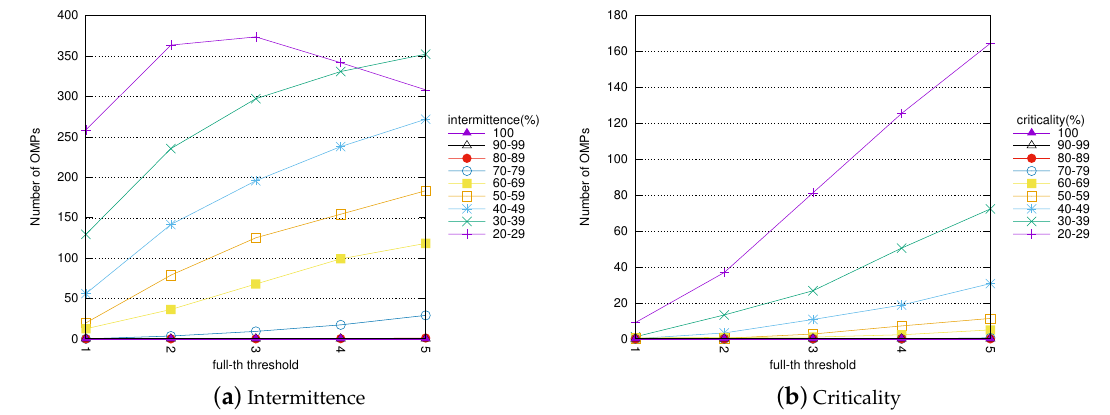
Figure 8. Barcelona. Impact of the occupancy threshold on the characteristics of the mined OMPs. maxdist = 0.5 km. time slot size = 1